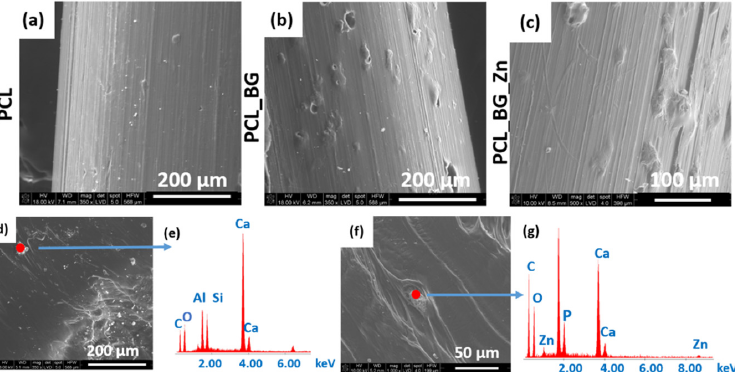
Figure 3. SEM micrographs of ( a ) PCL; ( b ) PCL_BG; ( c ) PCL_BG_Zn filaments along with the results of EDX analysis ( d , e ) PCL_BG; ( f , g ) PCL_BG_Zn.